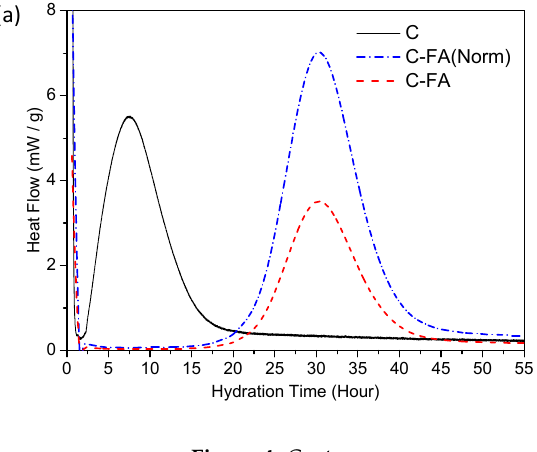
Figure 3. Amount of produced Ca(OH) 2 as a percentage of total weight in C and C-FA. The Ca(OH) 2 content was normalized against the C 3 S content of the pastes.